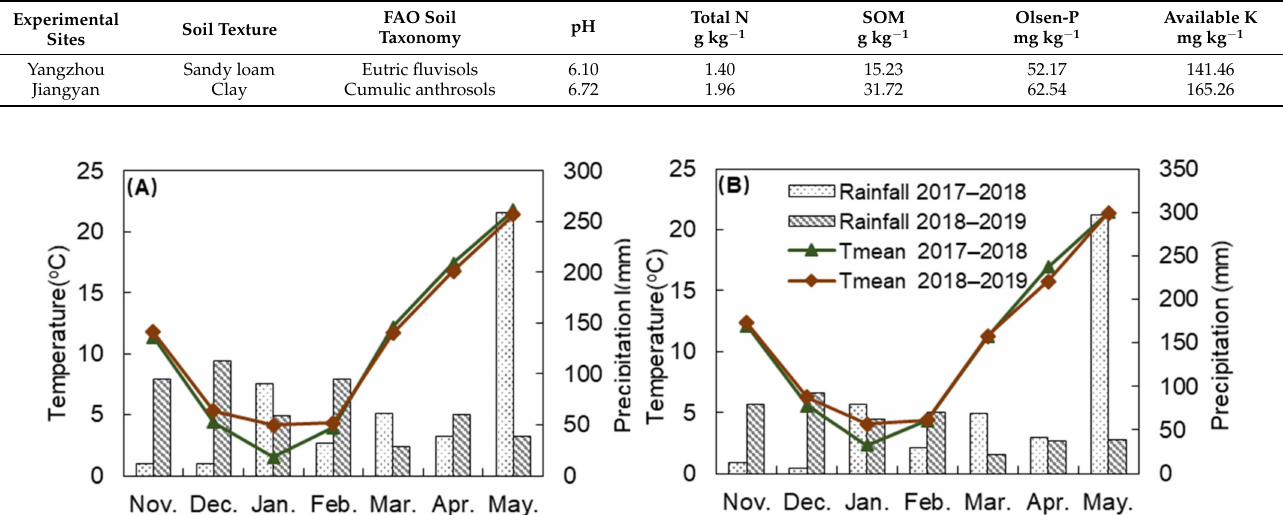
Figure 1. Monthly precipitation and average temperature at Yangzhou ( A ) and Jiangyan ( B ) sites in wheat growing seasons from 2017 to